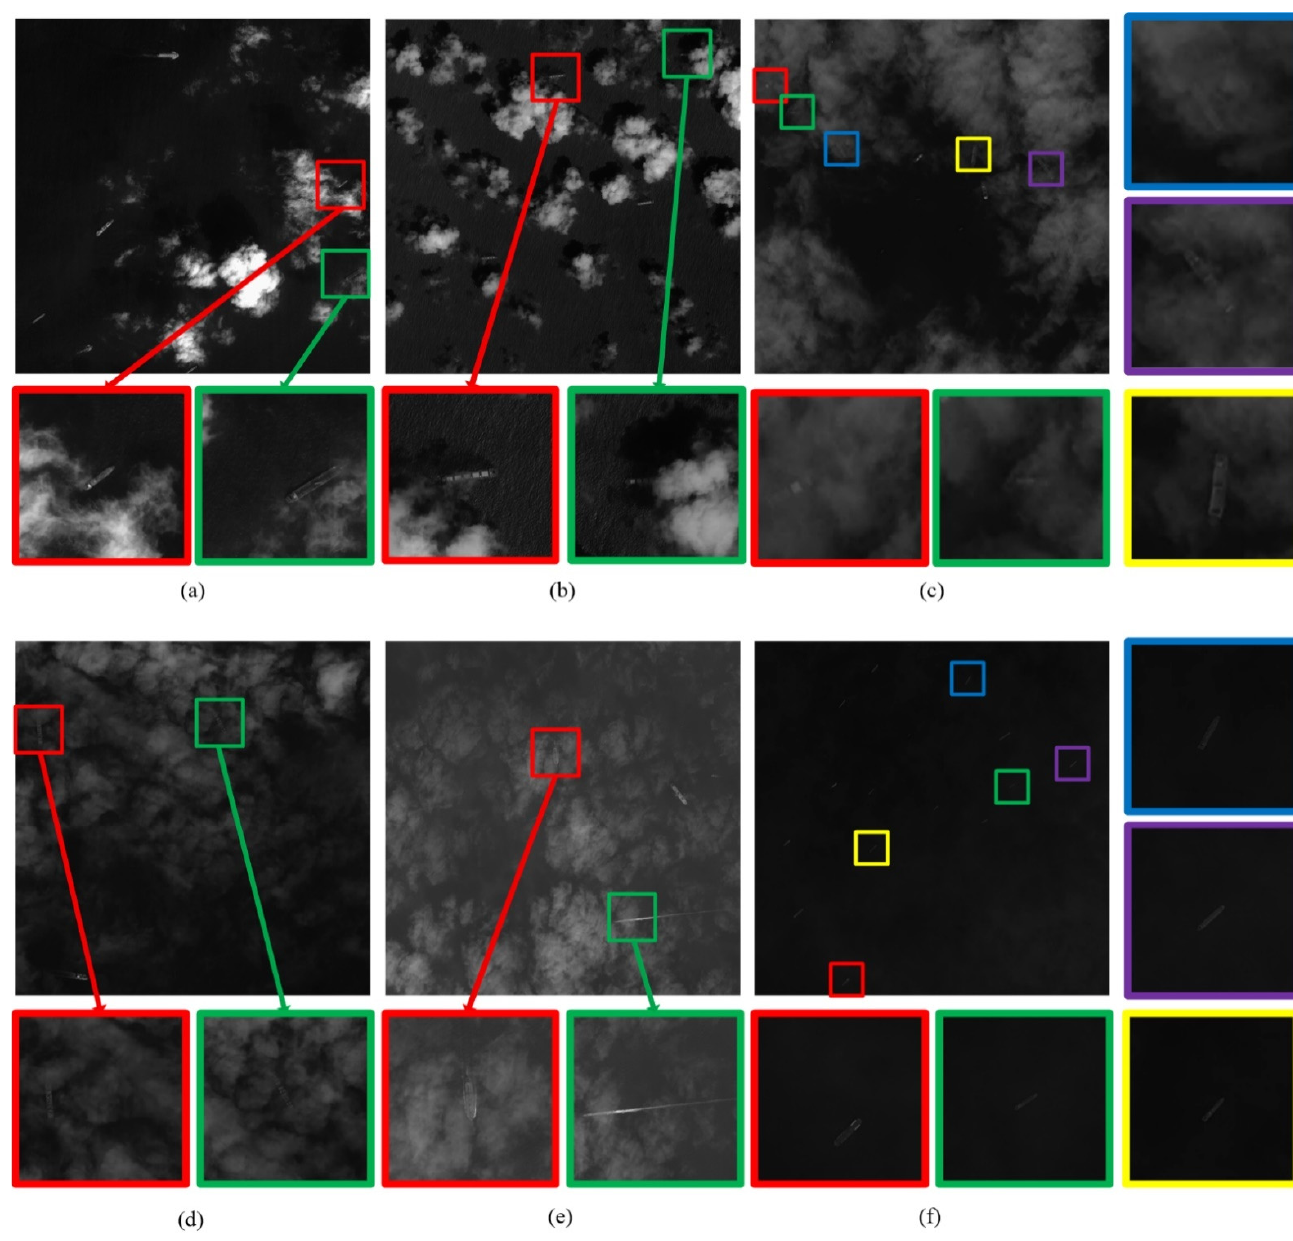
Figure 4. The panchromatic image corresponds to the color image in Figure 3 and the enlarged view of the details. Colored boxes are typical target areas; well-recognized targets are not marked and magnified. The target in ( a ) is connected to the cloud. The target framed in green in ( b ) is half of the hull occluded by the cloud. ( c – e ) are thin cloud coverage, in which part of the target is completely covered, but the outline of the entire hull is still recognizable. ( f ) is a low-contrast image, and the gray values of the target and background are relatively close.